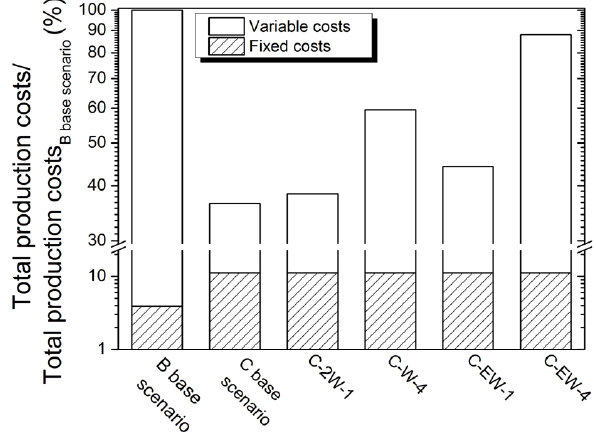
Figure 6. Total annual production costs of the batch and the micro-/milli-continuous campaign manufacturing process for writing ink varying the cleaning agent